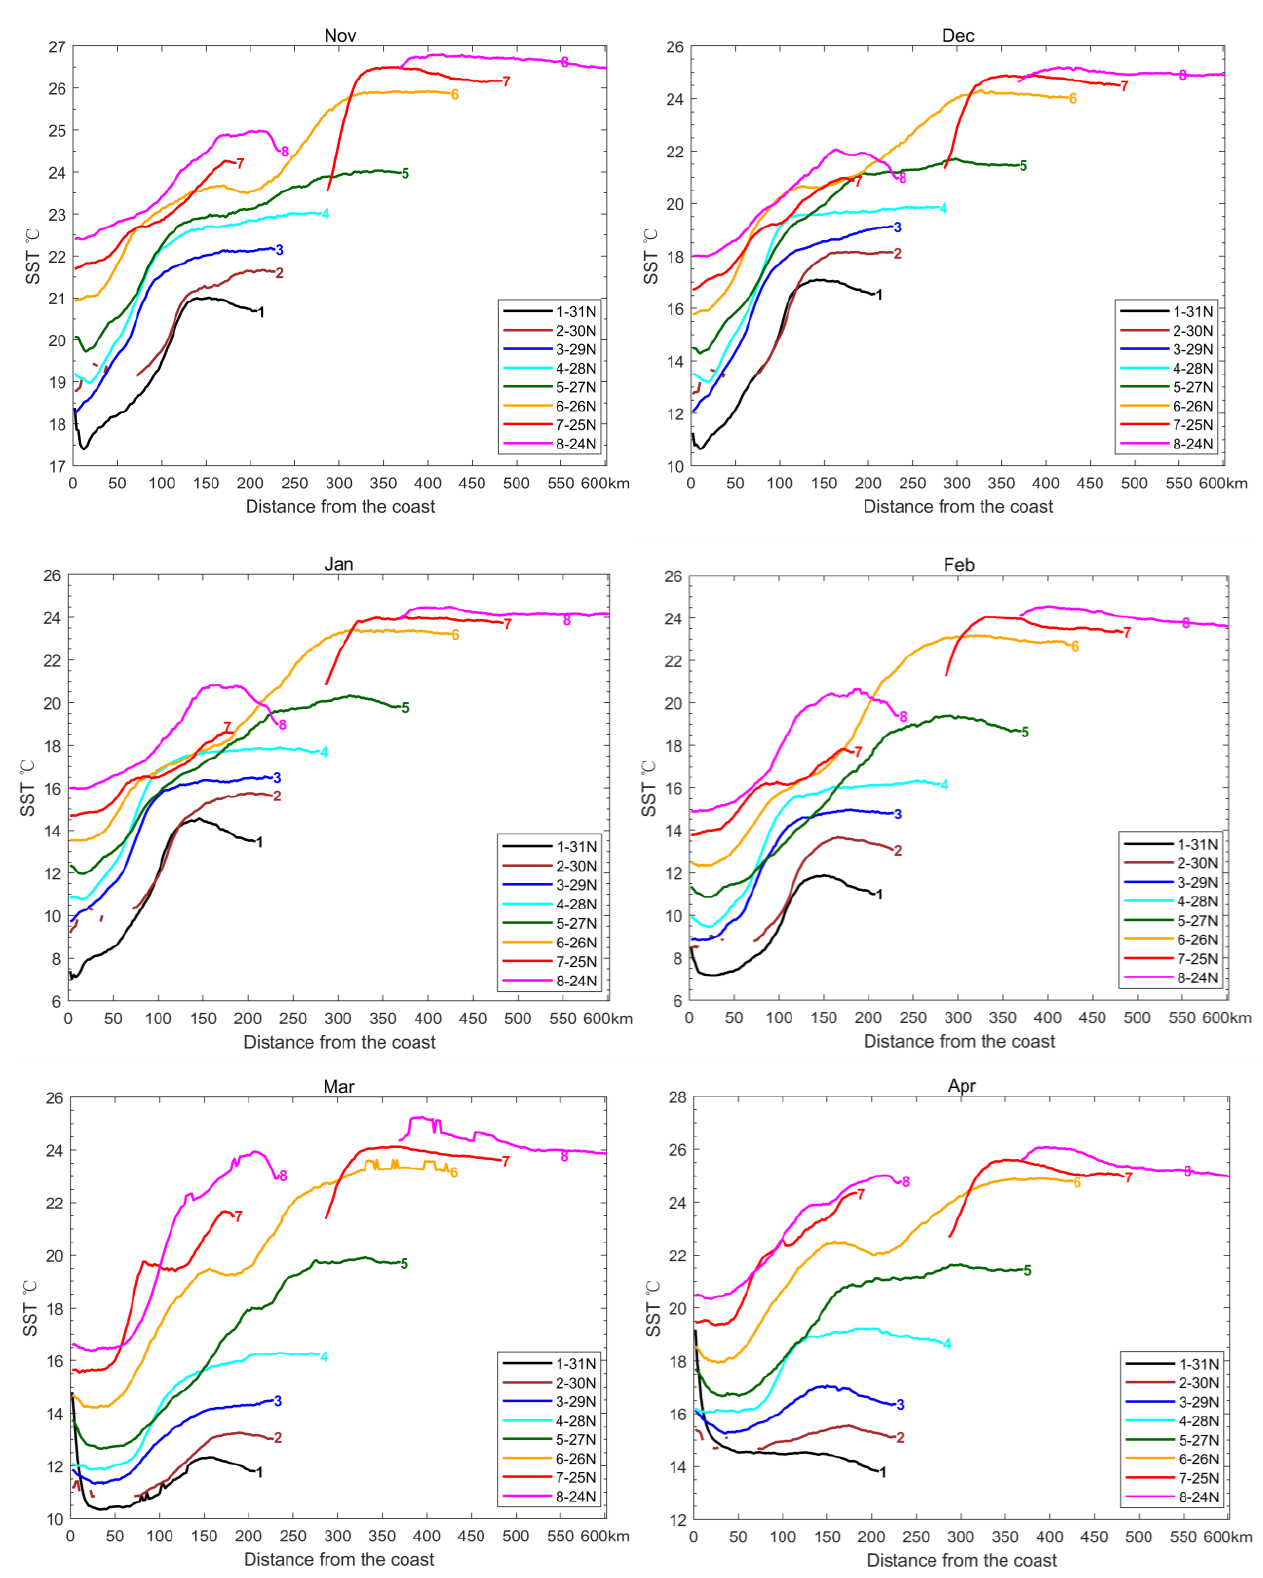
Figure 8. Long-term (2015 – 2020) mean monthly distributions of SST along the 8 zonal lines (Figure 7) across the CCF during winter months (November through April). The SST curve numbers in plot legends correspond to the zonal line numbers in Figure 7.